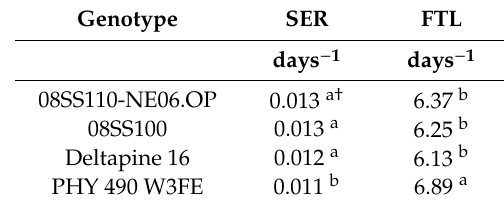
Table 3. Genotype e ff ect on seedling emergence rate (SER) and first true leaf (FTL) of cotton.